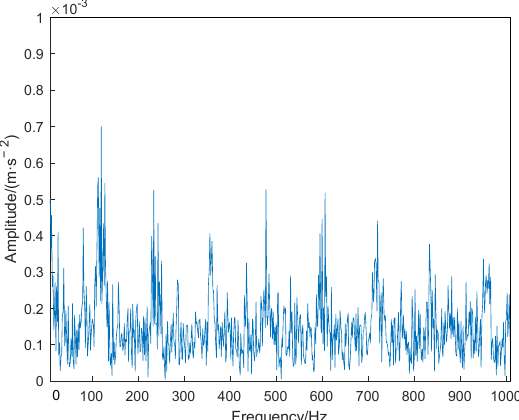
Figure 12. Envelope spectrum after direct MCKD processing.